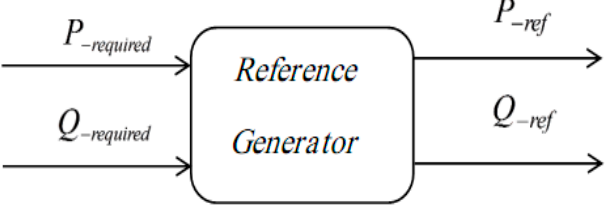
Figure 13. Production of the new power sources in an imbalance condition.